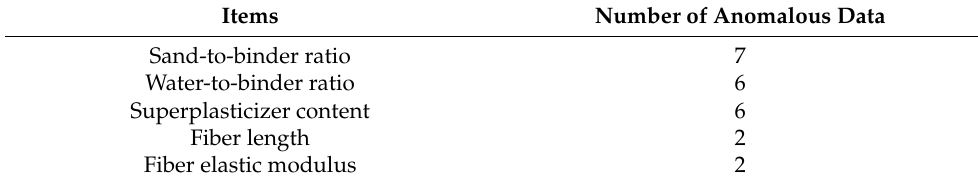
Table 2. Results of data anomaly detection.